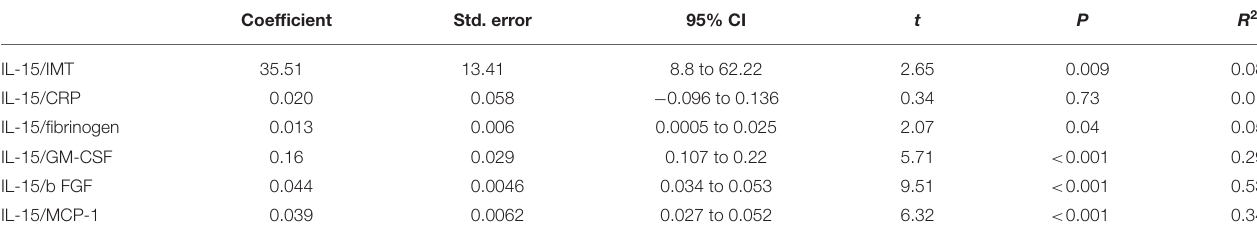
TABLE 2 | Predictions of IMT, CRP, fibrinogen, GM-CSF, b FGB, and MCP-1 by interleukin-15 levels.